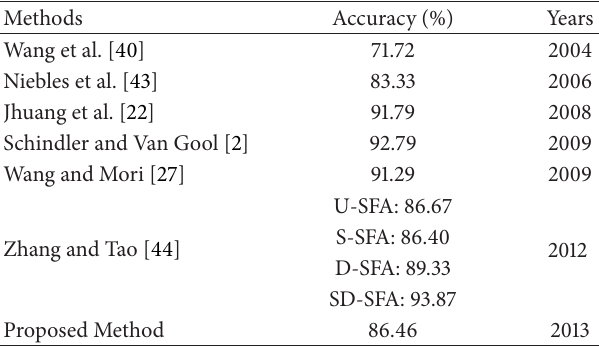
Table 1: The recognition results of proposed method has presented along with comparison between previous human action recognition method (Bio or non bio-inspired) on KTH human action dataset.